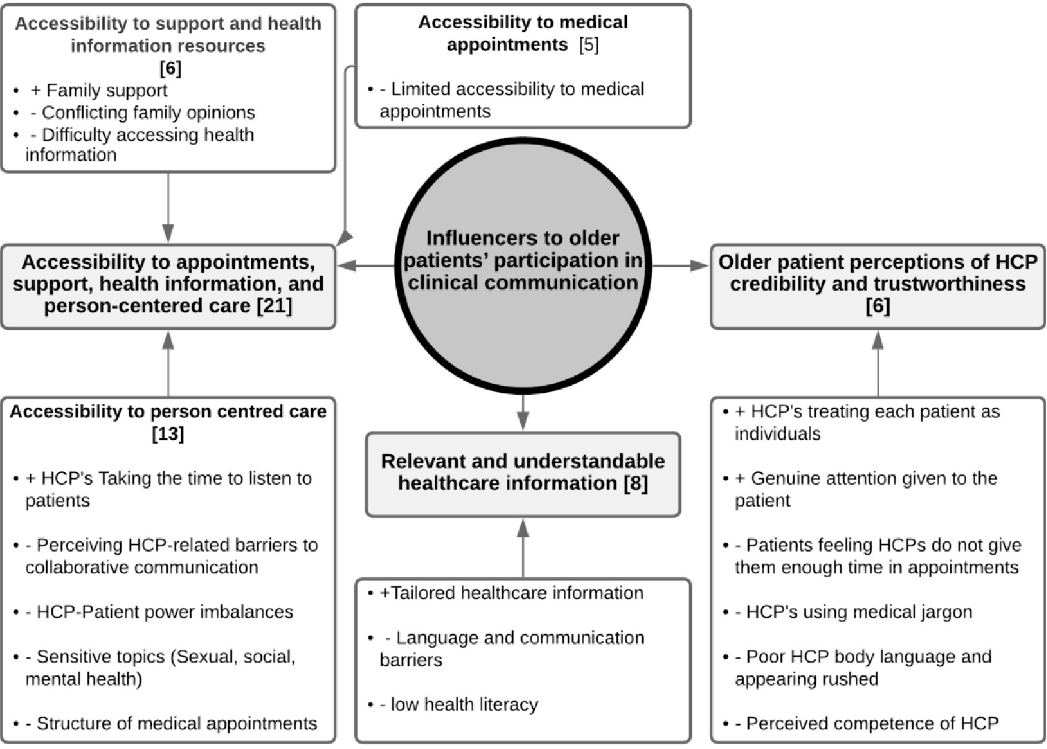
Fig 2. Flowchart highlighting number of studies that discussed each topic theme and sub-theme, and the influence (positive or negative) of each theme on older patient participation in clinical communication settings.